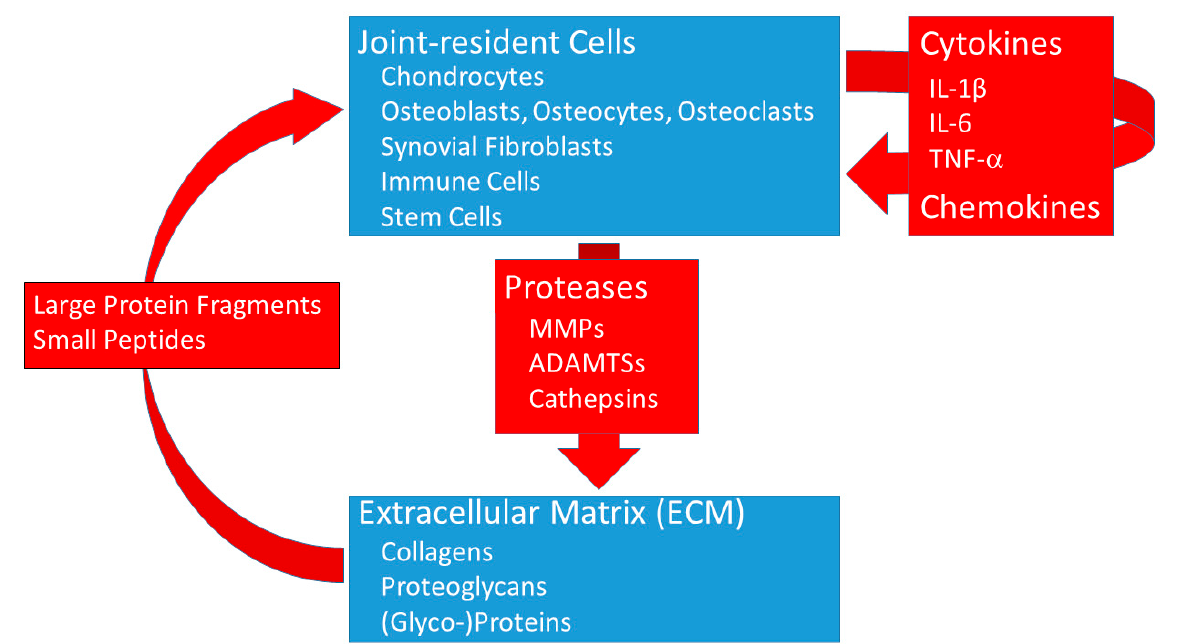
Figure 2. Proteases and cytokines in the joint. The different cell types present in the joint secrete proteases that degrade the complex cartilage extracellular matrix (ECM). This leads to a release of large protein fragments as well as the generation of small bioactive peptides. These degradation products can stimulate cells to produce more proteases and/or cytokines and chemokines that act either in an autocrine or paracrine manner and enhance the degeneration process in OA. In addition, cytokines and chemokines can influence the polarization of macrophages as well as the differentiation of stem cells. IL, interleukin; TNF, tumor necrosis factor; MMP, matrix metalloproteinase; ADAMTS, a disintegrin and metalloproteinase with thrombospondin motifs.